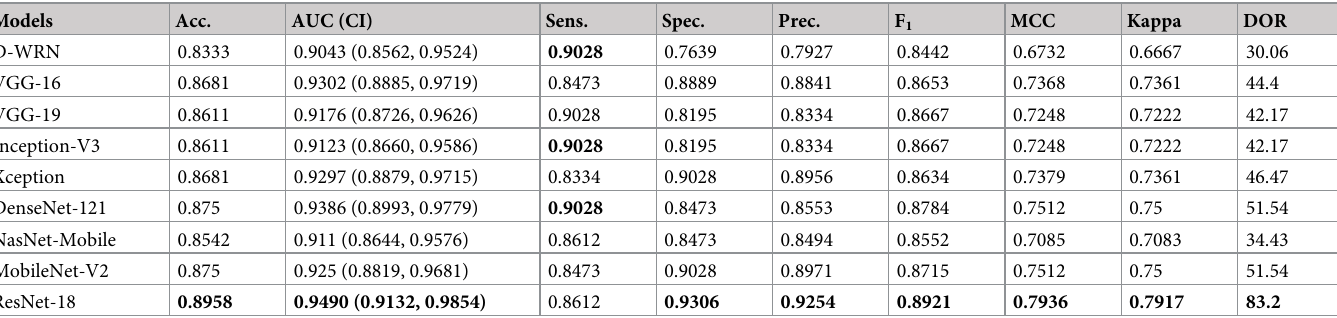
Bold numerical values denote best performances in the respective columns. Overall, ResNet-18 showed the best performance but individual metrics are not statistically different from other